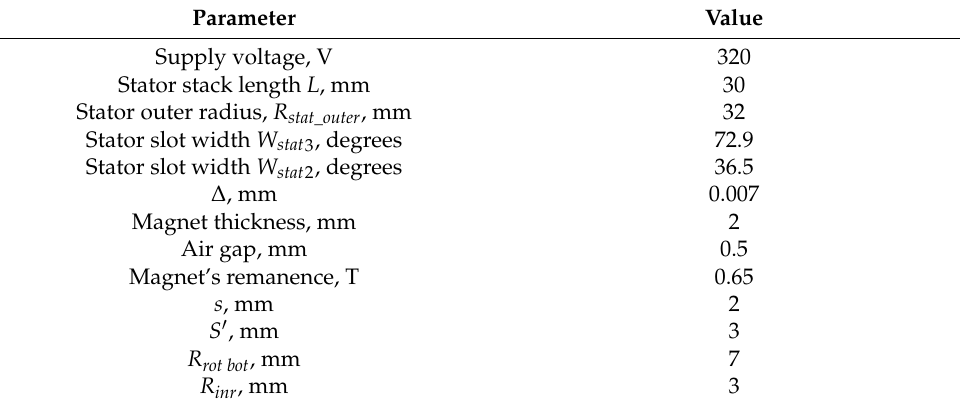
Table 3. Parameters that were fixed during the